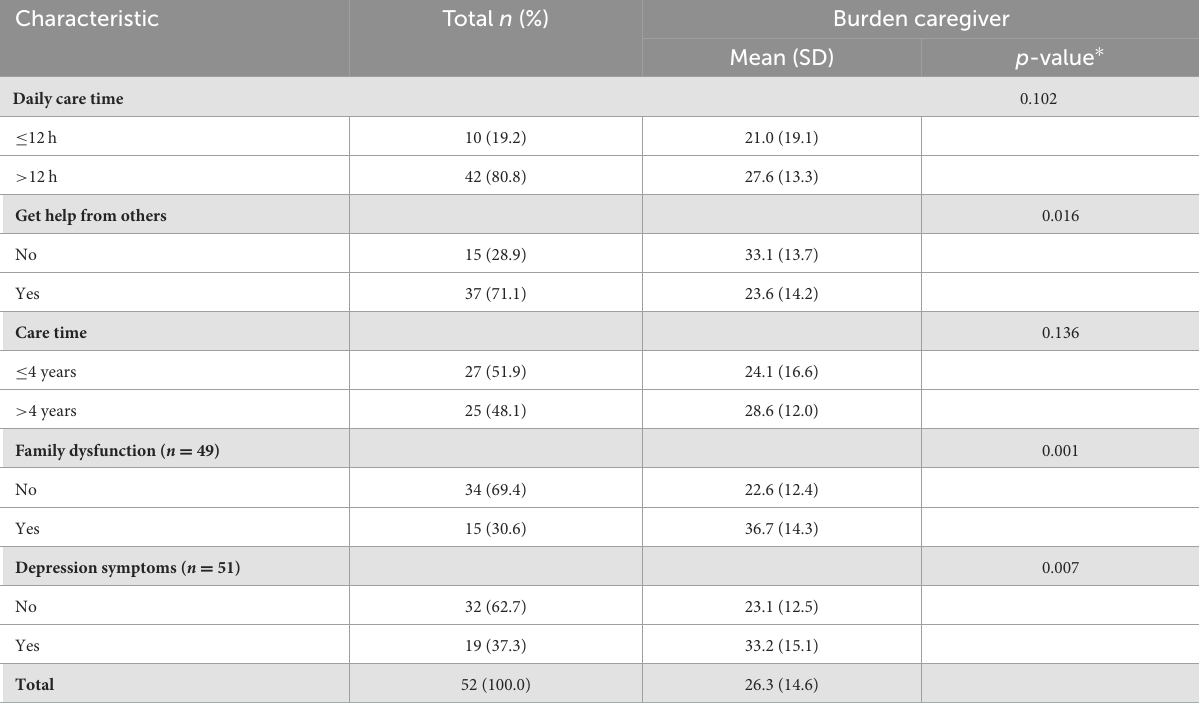
TABLE 2 Distribution of informal caregivers of older adults according to burdens, caregiving, family dysfunction, and depression symptoms. Palmas, Tocantins, Brazil ( n = 52). Characteristic Total n (%) Burden